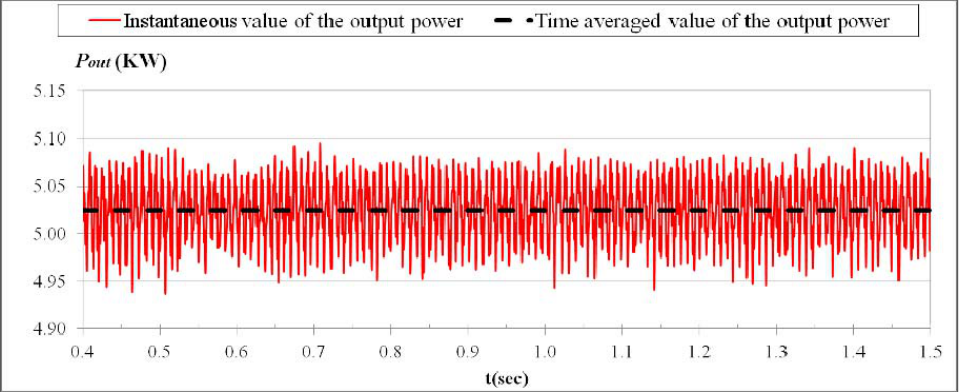
Figure 9. The time series of the output power P designed nozzle. The black dotted line represents the time averaged value of the output power P out